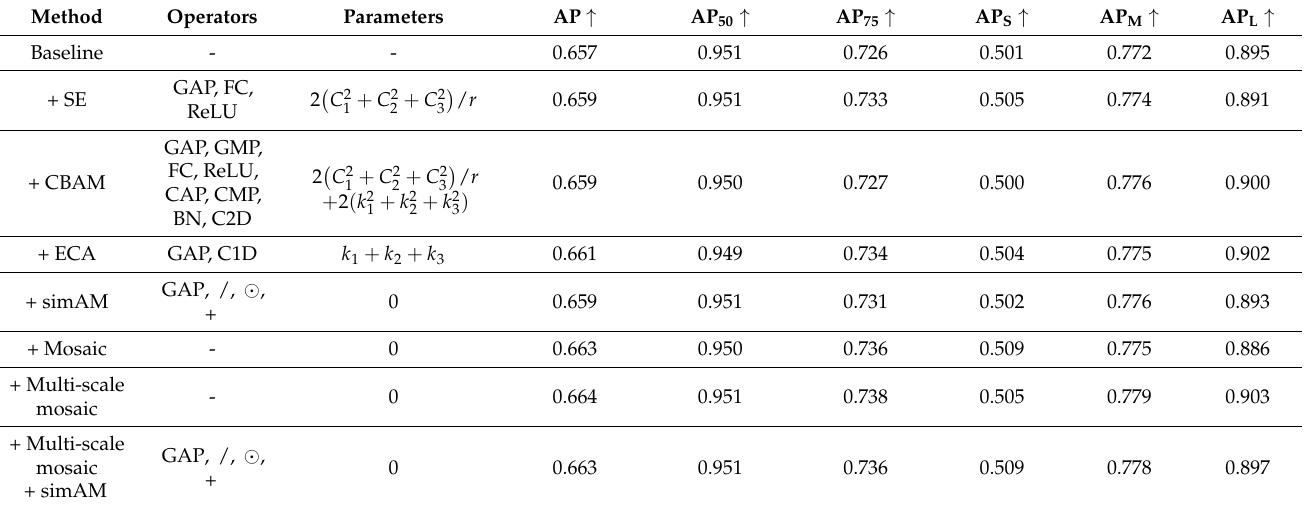
Table 2. Results of ablation experiment. “ ↑ ” indicates that the larger the value, the better the